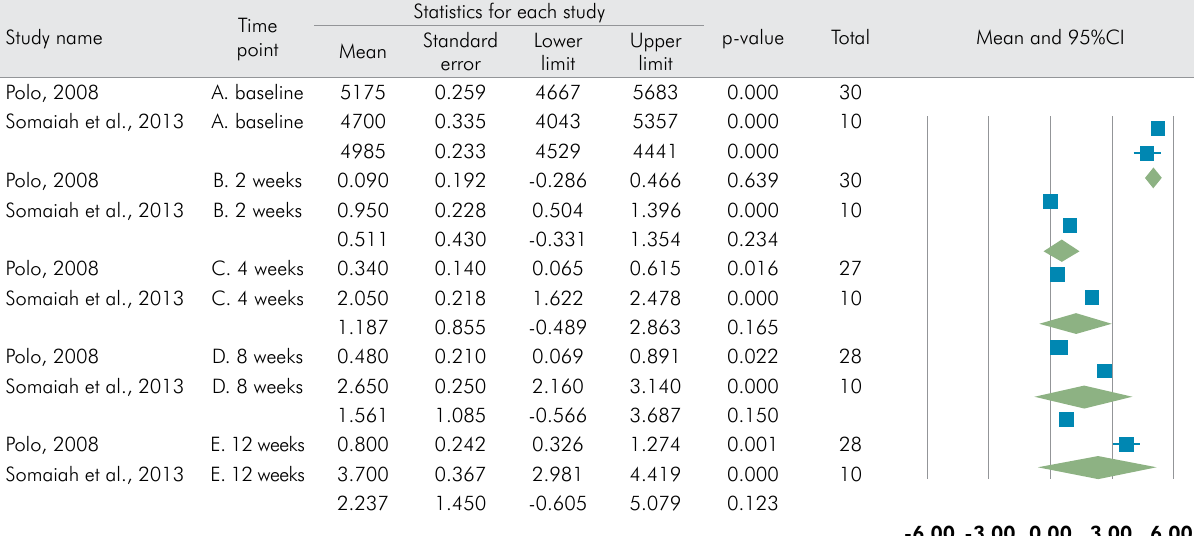
Figure 2. Comparison of average values for each time